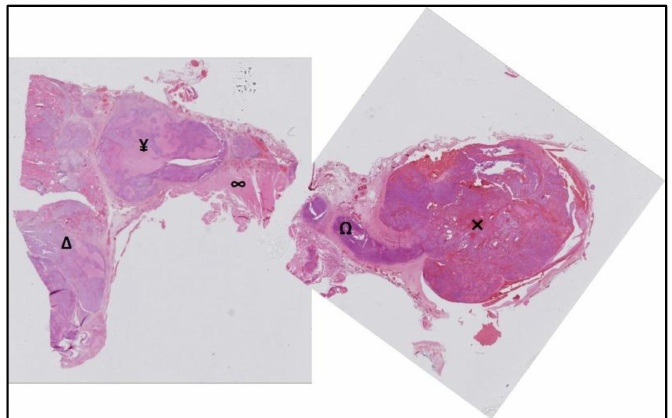
Figure 4. Post-operative pathology. Poorly differentiated follicular thyroid carcinoma ( ∆ ) with extrathyroidal extension (¥) coming into contact with the muscle ( ∞ ) and invading the IJV via the middle vein thyroid ( Ω ), creating a tumor thrombus ( × ) at this